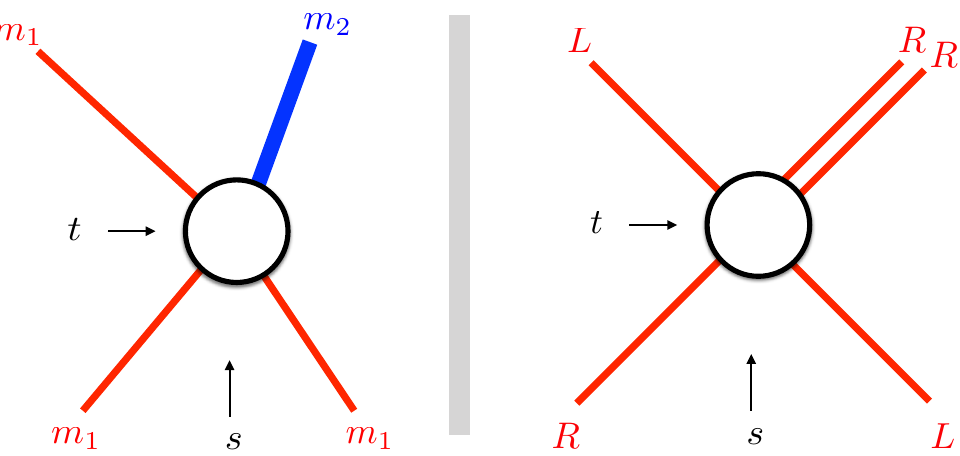
Figure 8 . The kinematics of the two-to-two process 11 → 12 is very reminiscent of two-to-three scattering of massless particles as illustrated here. Both processes are fully crossing symmetric. Particle 2 on the left is analogous to the jet of two right-movers on the right. This two-to-three scattering process should show up in flux tube physics [32–34] where parity is broken. Extending the flux tube S-matrix boostrap program initiated in [35] to include such processes would be extremely